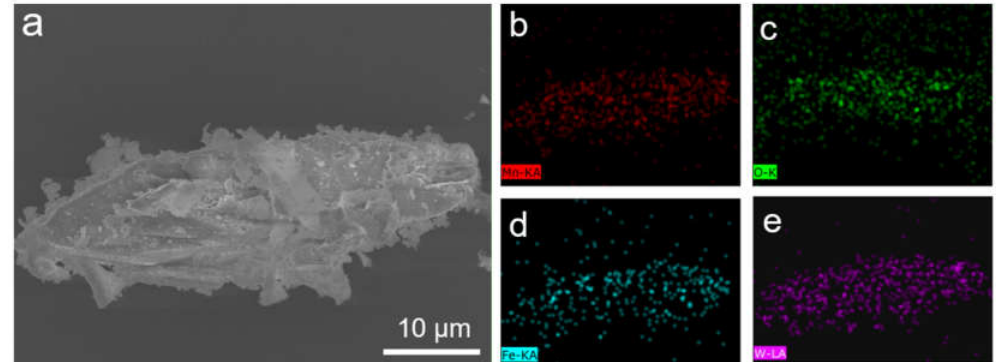
Figure 2. SEM image of natural wolframite ( a ) and energy dispersive X-ray spectrometry (EDX) mapping of different elements ( b – e ).